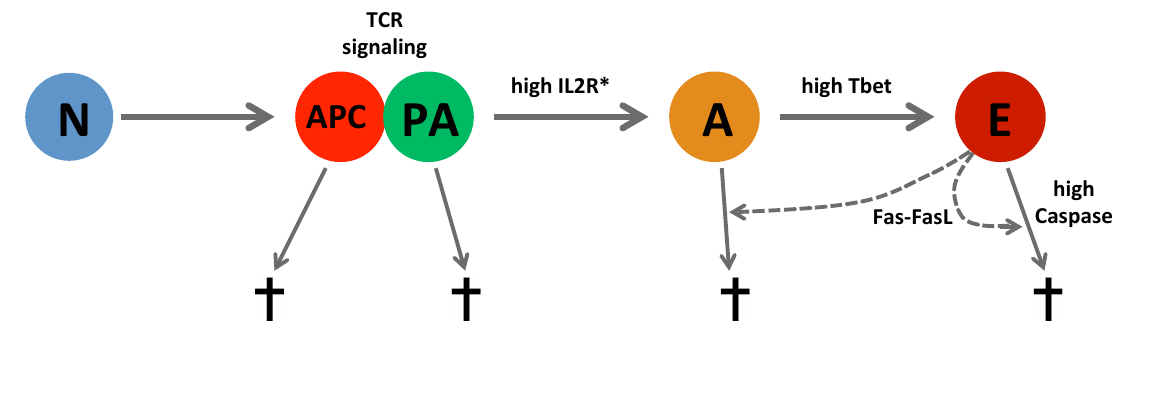
Figure 3. Schematic diagram of the linear activation pathway for the CD8 T-cells. Due